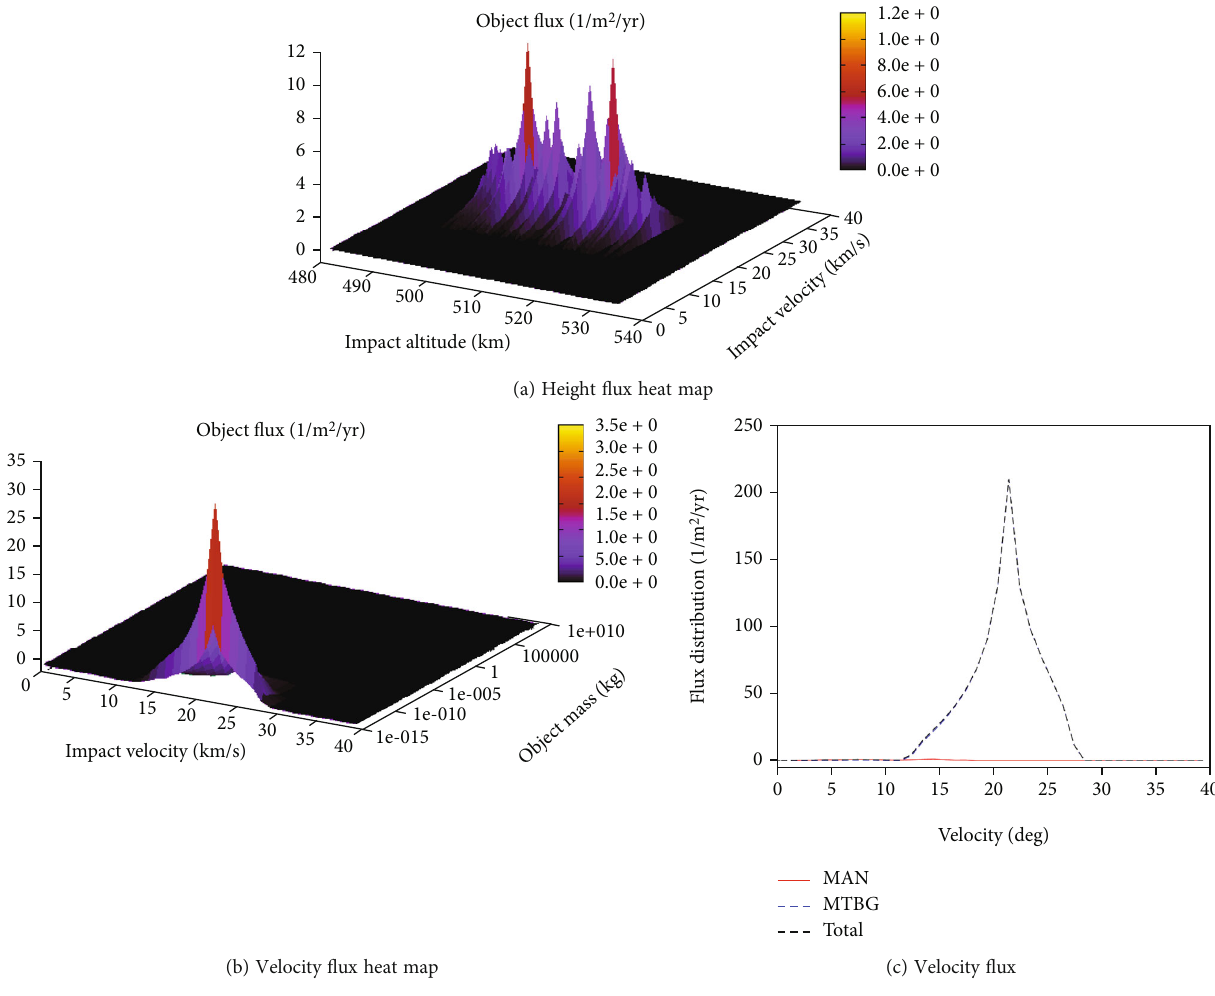
Figure 8: Fluxes of debris impact height and impact